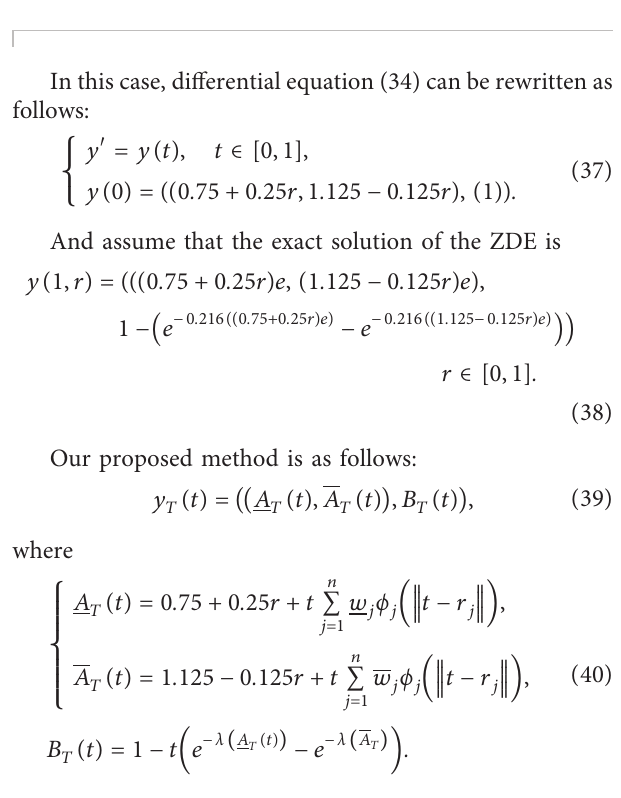
Comparison of the approximate solution with the RBF network training for 50 points and with a choice of λ � 1 is shown in Table 2. The convergence of the neural network weights for each r -cut is shown in Figure 2. Comparison of the approximate method with the exact method is shown in Figure 3. The comparison of the confidence level of the actual answer and the approximate solution is shown in Figure